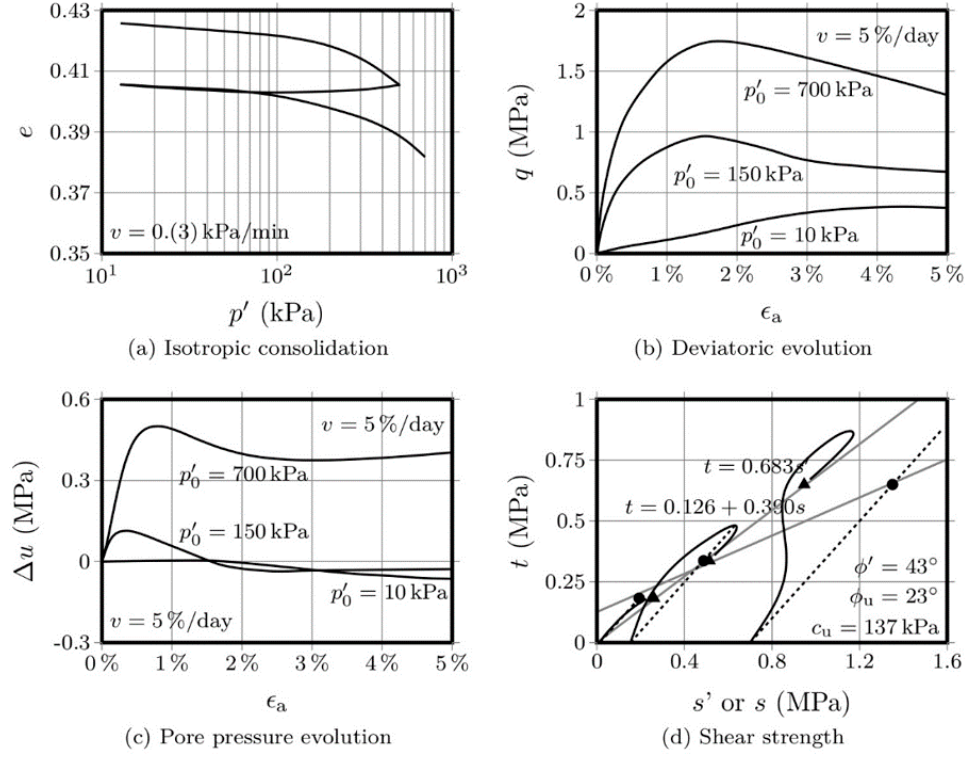
Figure 6. CIU triaxial tests performed on the AAC-S material after 28 days curing.